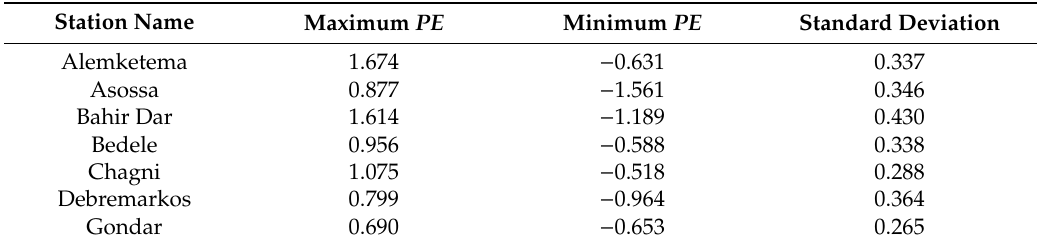
Table 5. The maximum, minimum, and standard deviation values of the prediction error ( PE ).